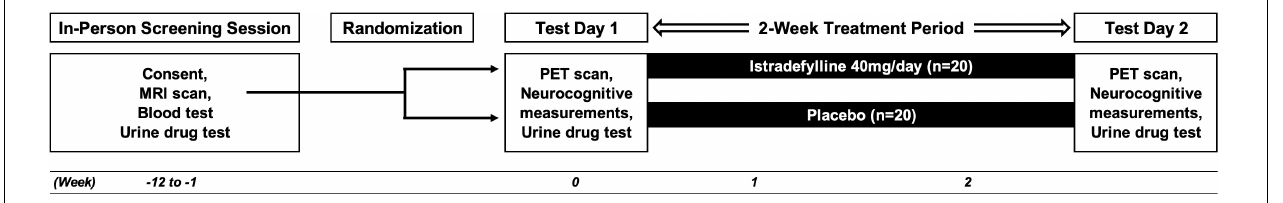
TABLE 1 | Schedule of enrollment and assessment.